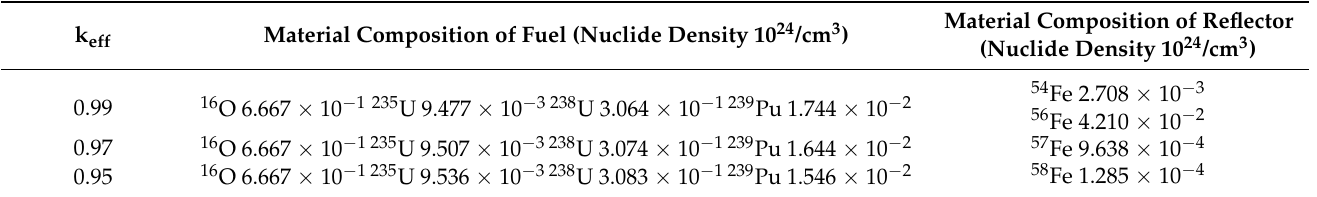
Table 2. ADSR material composition with thermal spectrum for three core loading schemes. k eff Material Composition of Fuel (Nuclide Density 10 24 /cm 3